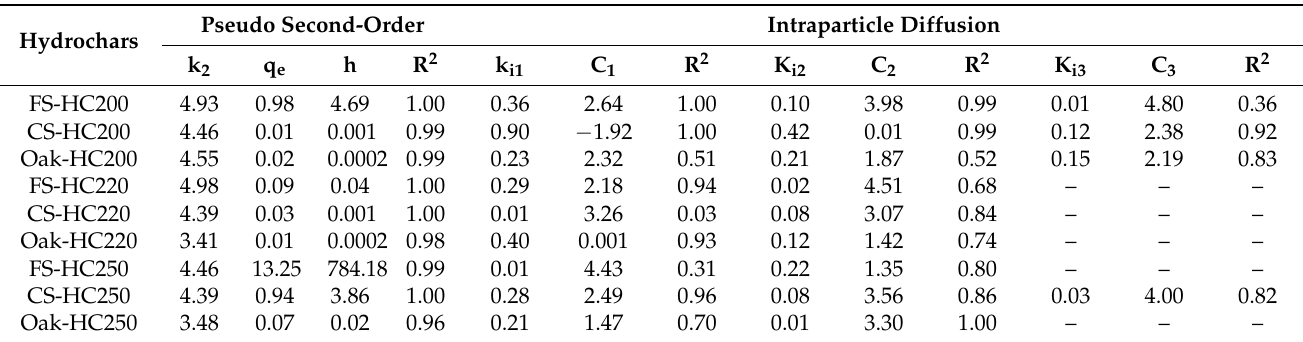
Table 1. Comparison of kinetic parameters for adsorption of MB dye onto FS-HCs, CS-HCs, and Oak-HCs.